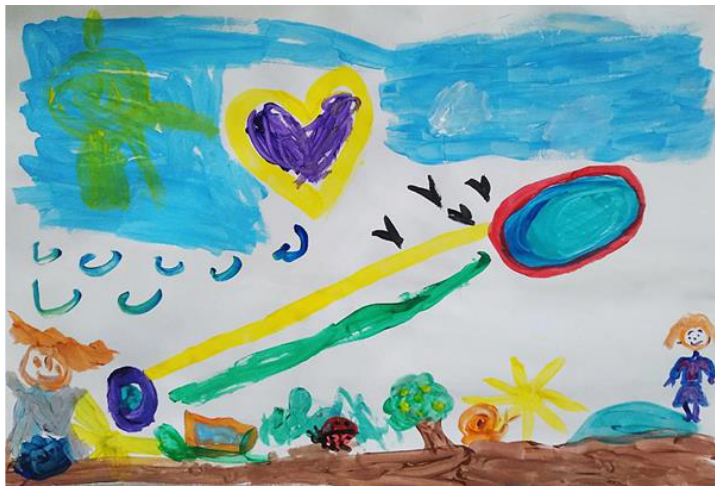
Figure 2. Naama and her mother.